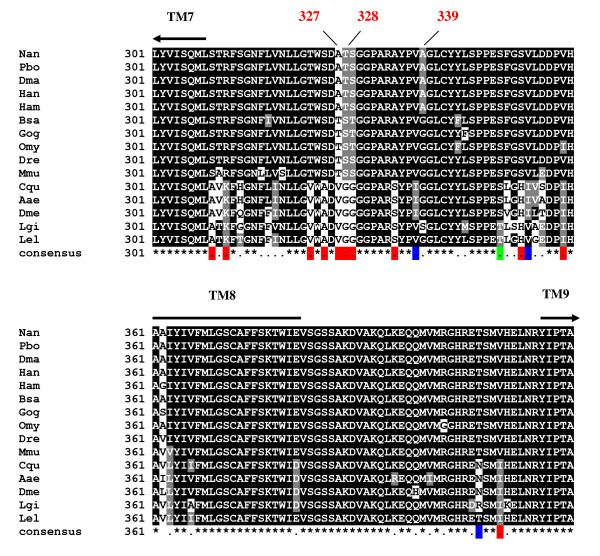
Amino acid alignment of the region between transmembrane (TM) regions 7 and 9 of the α sub-unit of SEC61. Putative cold-adapted amino acid substitutions are indicated at positions 327, 328 and 339. Invertebrate-specific substitutions are labelled in red on the consensus line, insect-specific substitutions labelled in blue and the single potential bivalve-specific substitution labelled in green. Species abbreviations and accession numbers: Nan: Notothenia angustrata (Q8AY35); Pbo: Pagothenia borchgrevinki (Q8AY36); Dma: Dissostichus mawsoni (AY113841); Han: Harpagifer antarcticus (Q7T278); Ham: Hemitripterus americanus (Q8AY34); Bsa: Boreogadus saida (Q8AY33); Gog: Gadus ogac (Q8AY32) (all cold-adapted); Omy: Onchorhynchus mykiss (Q98SN9); Dre: Danio rerio (Q90ZM2); Mmu: Mus musculus (P61620); Cqu: Culex quinquefasciatus (B0WNA0); Aae: Aedes aegypti (Q17CM3); Dme: Drosophila melanogaster (Q8STG9). Lgi: Lottia gigantea (cluster: >jgi|Lotgi1|194715|estExt_Genewise1.C_sca_610223 from sequences: 4236761:1772, 4236761:2059 and 4236761:4476 extracted from http://genome.jgi-psf.org/Lotgi1/Lotgi1.home.html; Lel: Laternula elliptica, contig00029.